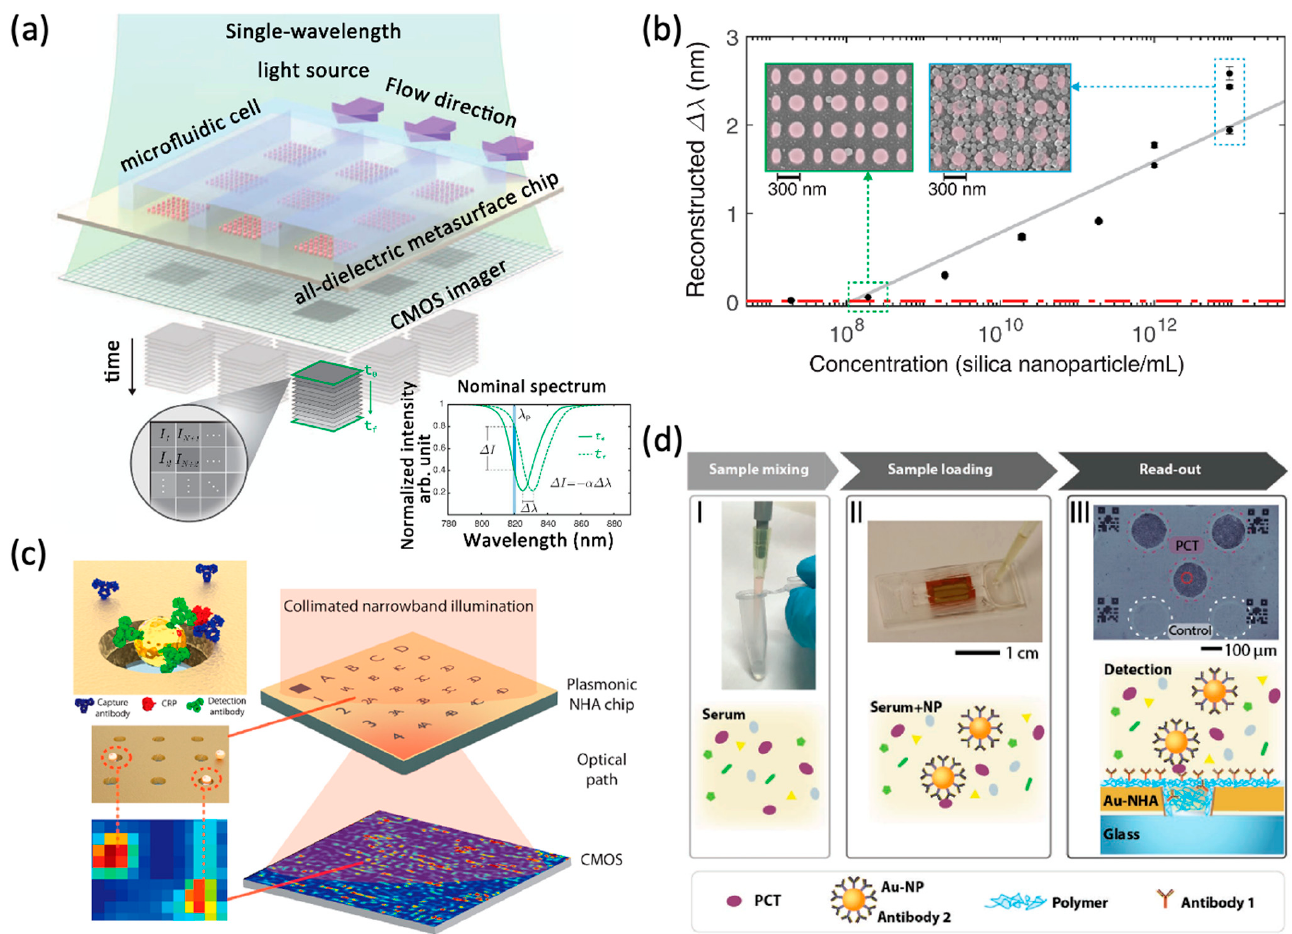
Figure 3. Metasurface-based refractometric microscopy for biomolecular sensing. ( a ) The single- wavelength algorithm with spectral displacement reconstruction assists the principle of imaging biosensors. A sketch of the real-time flow into the imaging platform shows a 2D microarray of all- dielectric sensors integrated with a microfluidic unit composed of three independent flow channels. Biomarker binding can be detected by tracking the resonance wavelength or by the intensity change